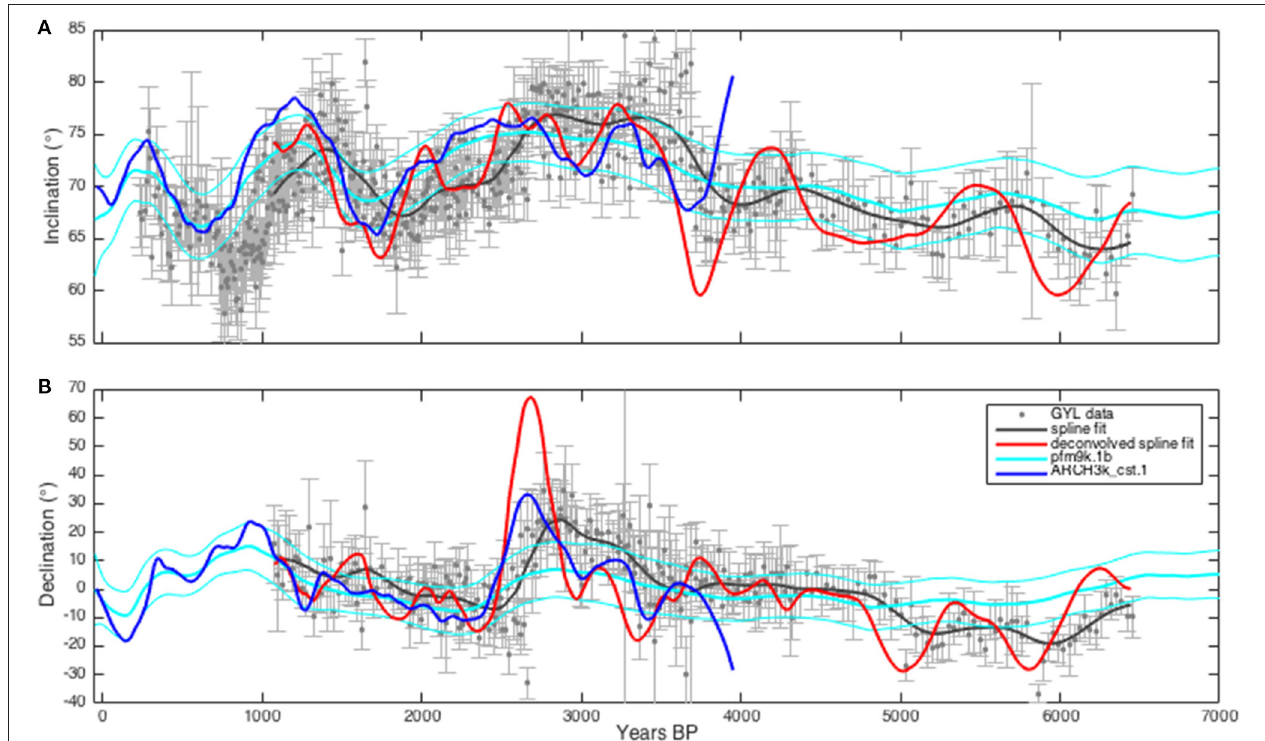
FIGURE 7 | (A) Inclination and (B) declination data (filled gray circles) with 1 σ error from Lake Gyltigesjön. A smoothing spline fitted to the data (solid dark gray) deconvolved using the half lock-in depth ( l 28) and lock-in shape ( β 1.3) with highest probability from Figure 6C (solid red). The pfm9k.1b (solid cyan) and ≈ ≈ ARCHk_cst.1 (solid blue) geomagnetic field model predictions with 1 σ uncertainty envelope (pfm9k.1b) are shown for comparison.